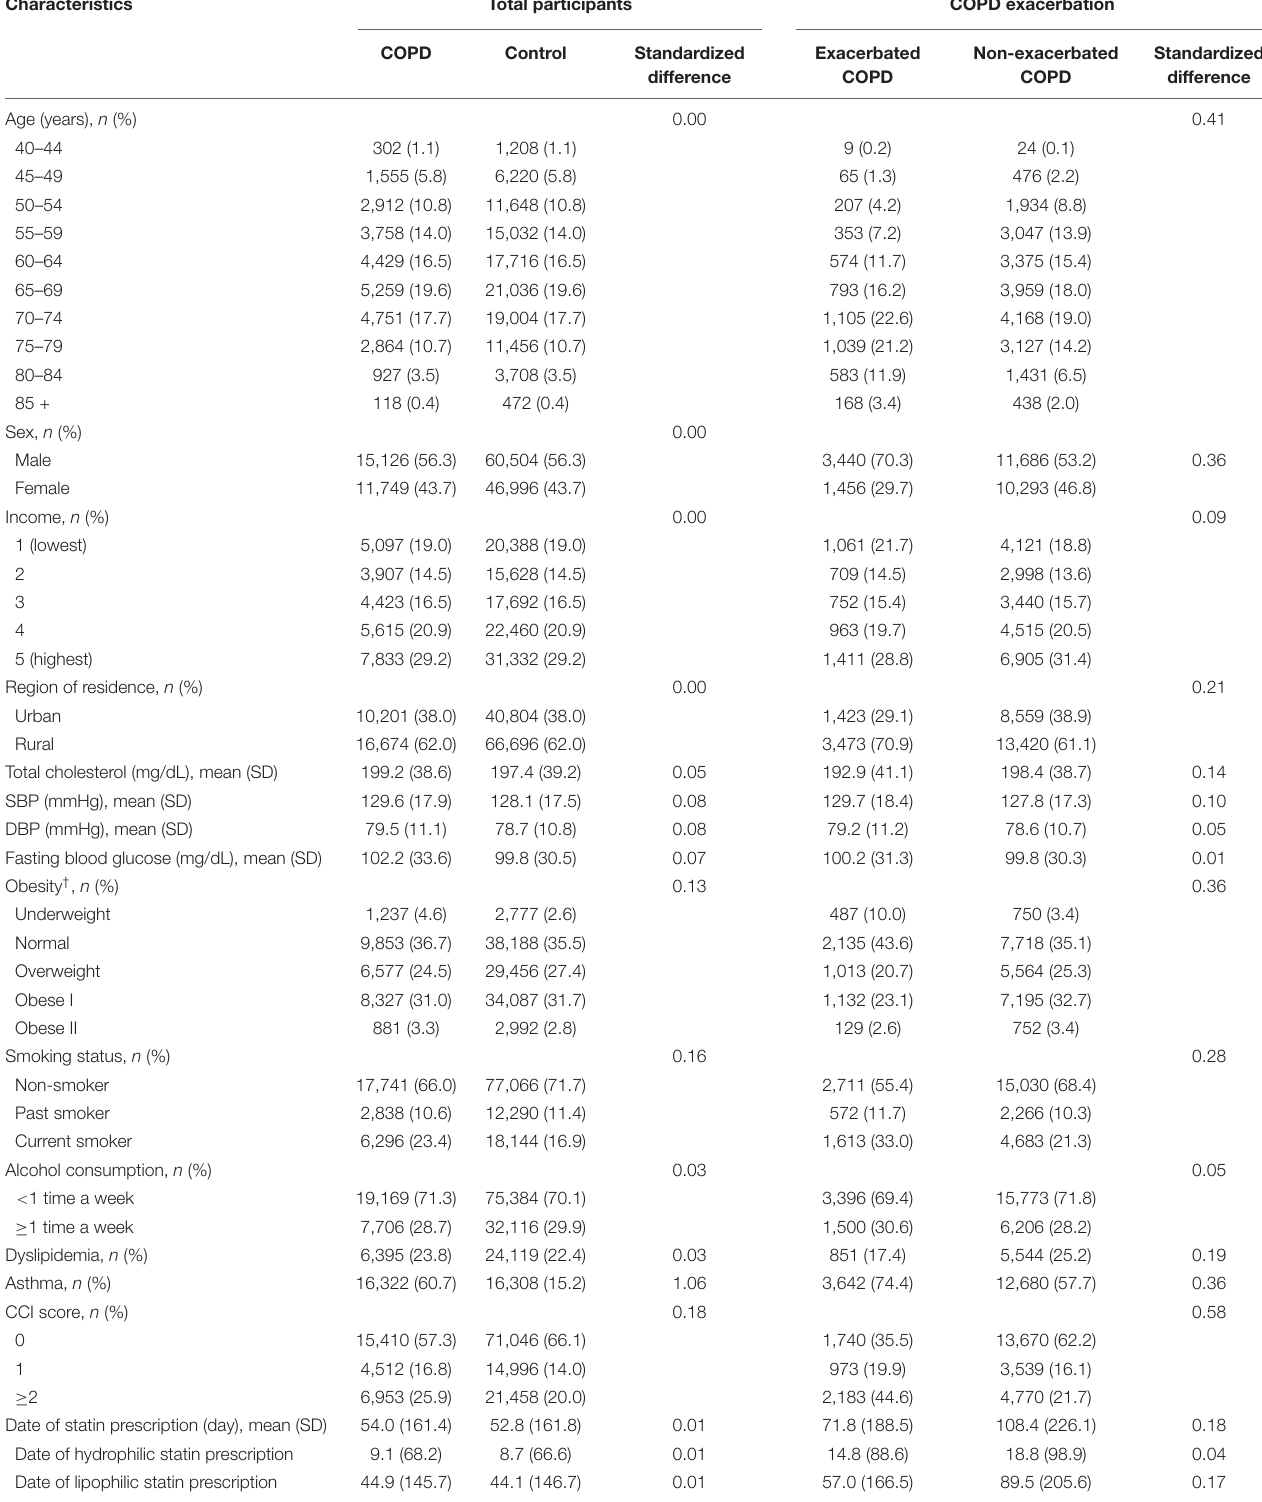
TABLE 1 | General characteristics of